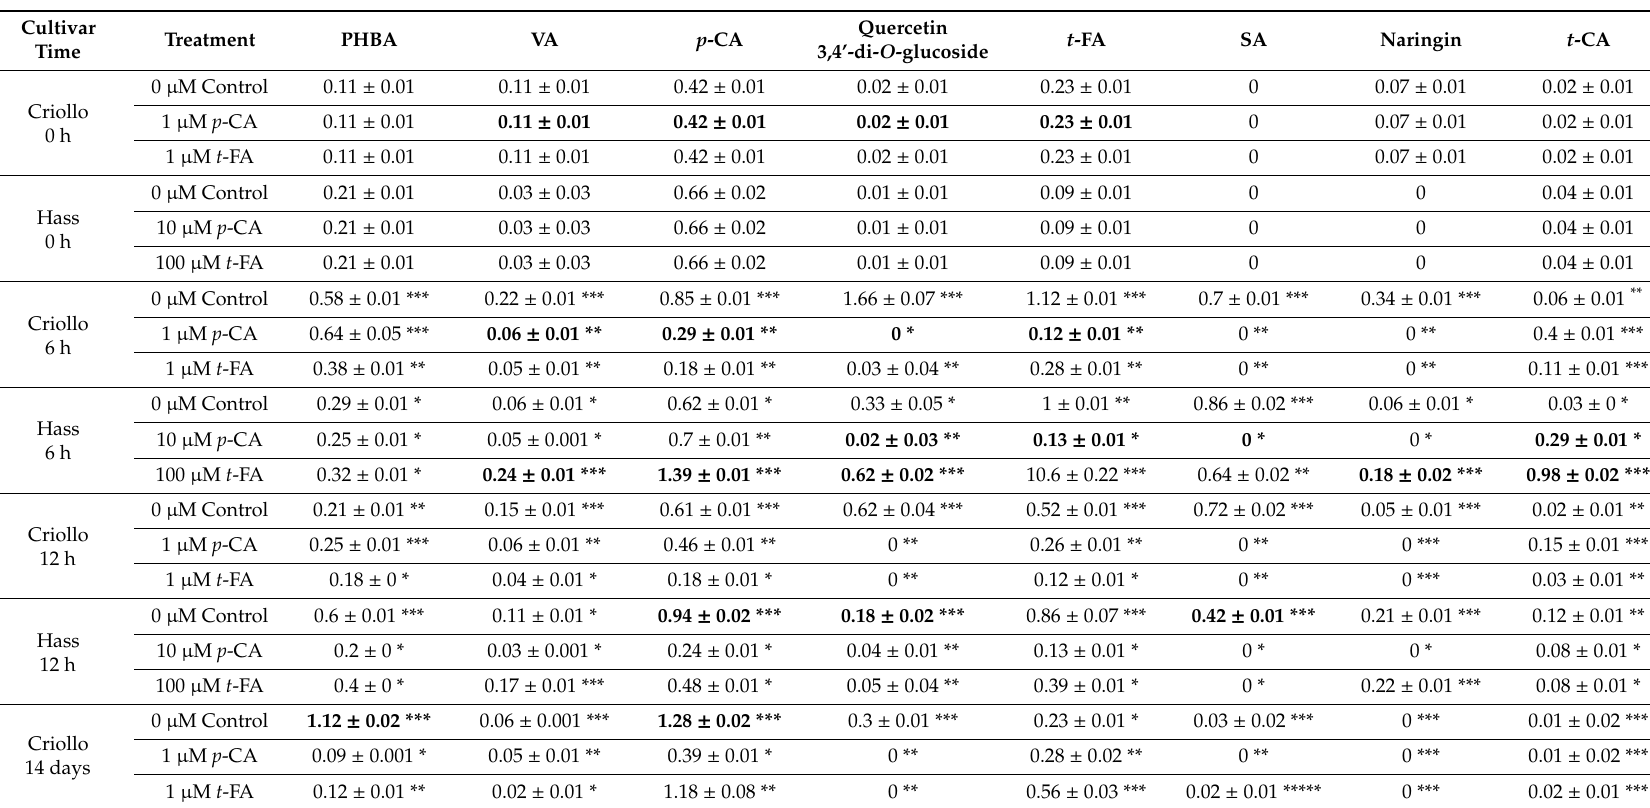
Table 1. The endogenous concentration of phenolic compounds (mg g − 1 fresh weight) in embryogenic cultures of Criollo and Hass avocado treated with di ff erent concentrations of p -coumaric (1 and 10 µ M) and trans -ferulic acid (10 and 100 µ M) during 6 and 12 h, and 14 and 28 days. The analysis was carried out with dynamic multiple reaction monitoring (dMRM) study. Replicate values, error standard and statistic values are presented in Table S2. p -hydroxybenzoic acid (PHBA), vanillin (VA), p -coumaric acid ( p -CA), trans -ferulic acid ( t -FA), SA (Sinapic acid) and trans -cinnamic acid ( t -CA). We indicated in bold and italic the values described in the